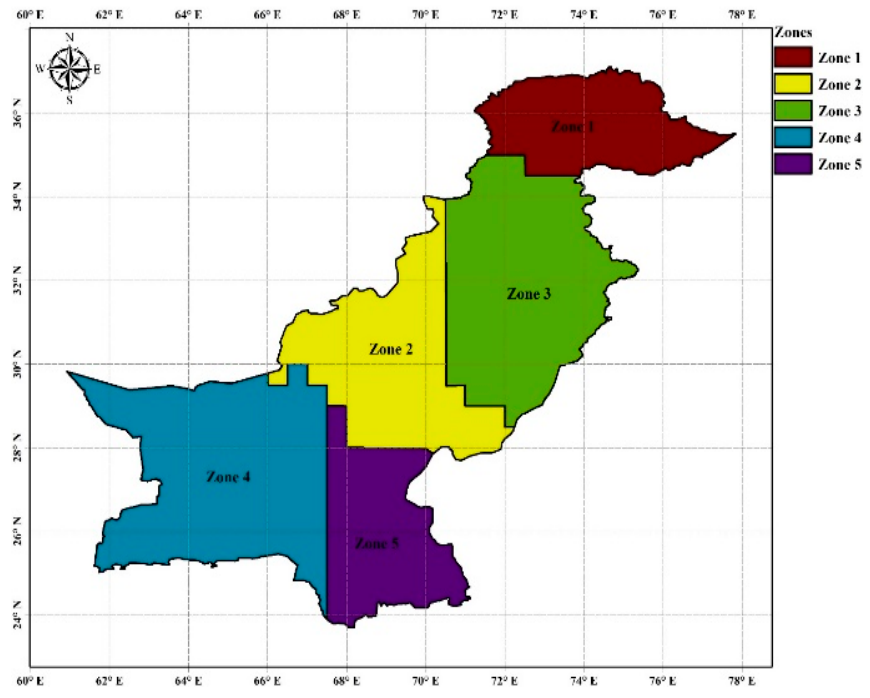
Figure 6. Zones produced after regionalization.